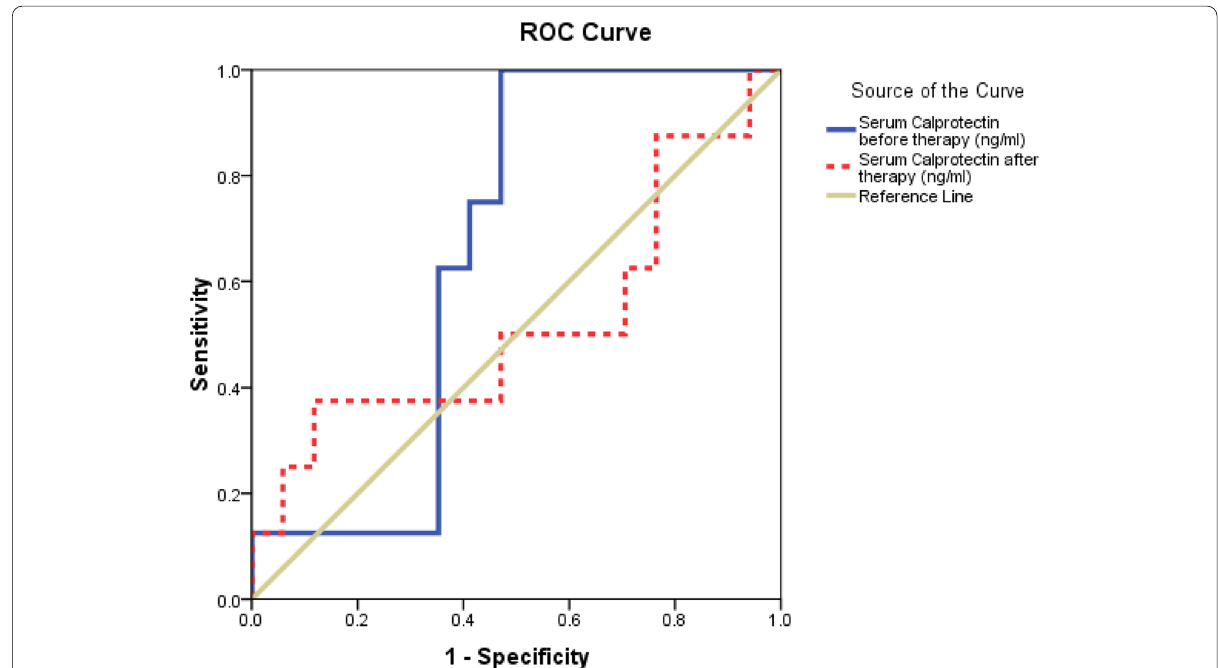
Fig. 4 Receiver operating characteristic (ROC) curve for serum calprotectin levels before and after biologic therapy. Before starting bDMARDs, the area under the curve (AUC) was 0.654 (95% CI 0.437–0.872); P